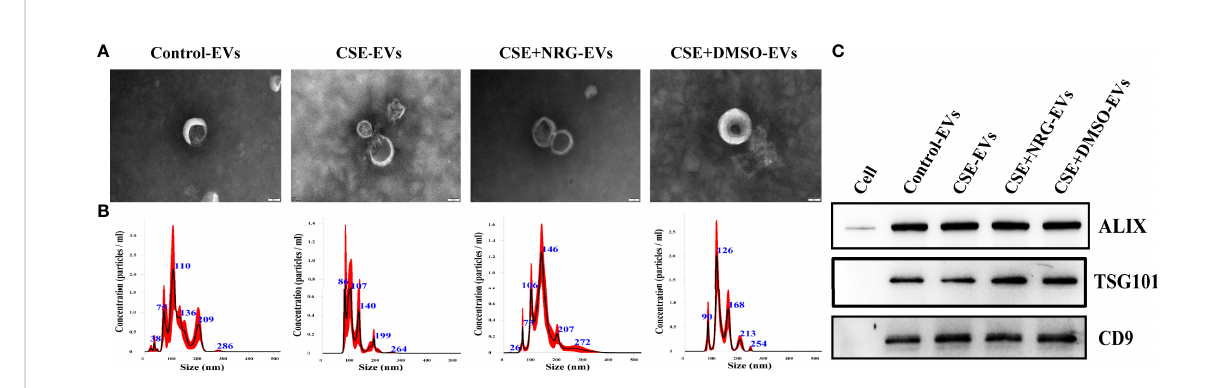
FIGURE 1 The characterization of BEAS-2B-derived EVs. (A) The morphology of EVs imaged by transmission electronic microscopy. Scale bar = 50 nm. (B) The size distribution and concentration of EVs were measured by nanoparticle tracking analysis. (C) ALIX, TSG101, and CD9 were detected by western blotting. BEAS-2B cellular total protein was used as a negative control.